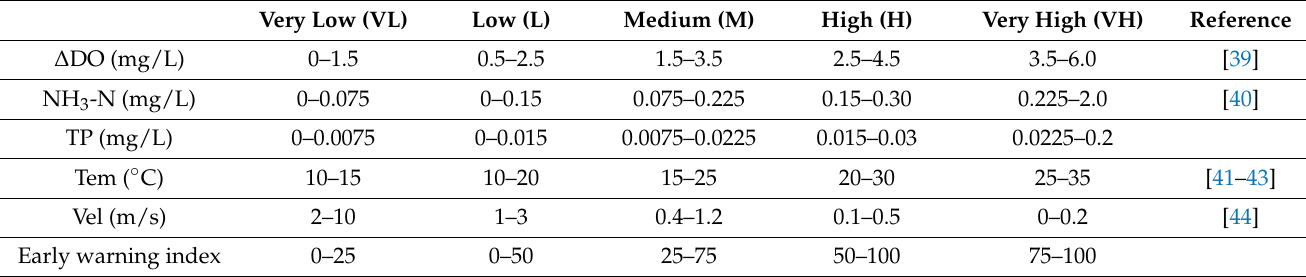
Table 2. Input variables and the corresponding fuzzy